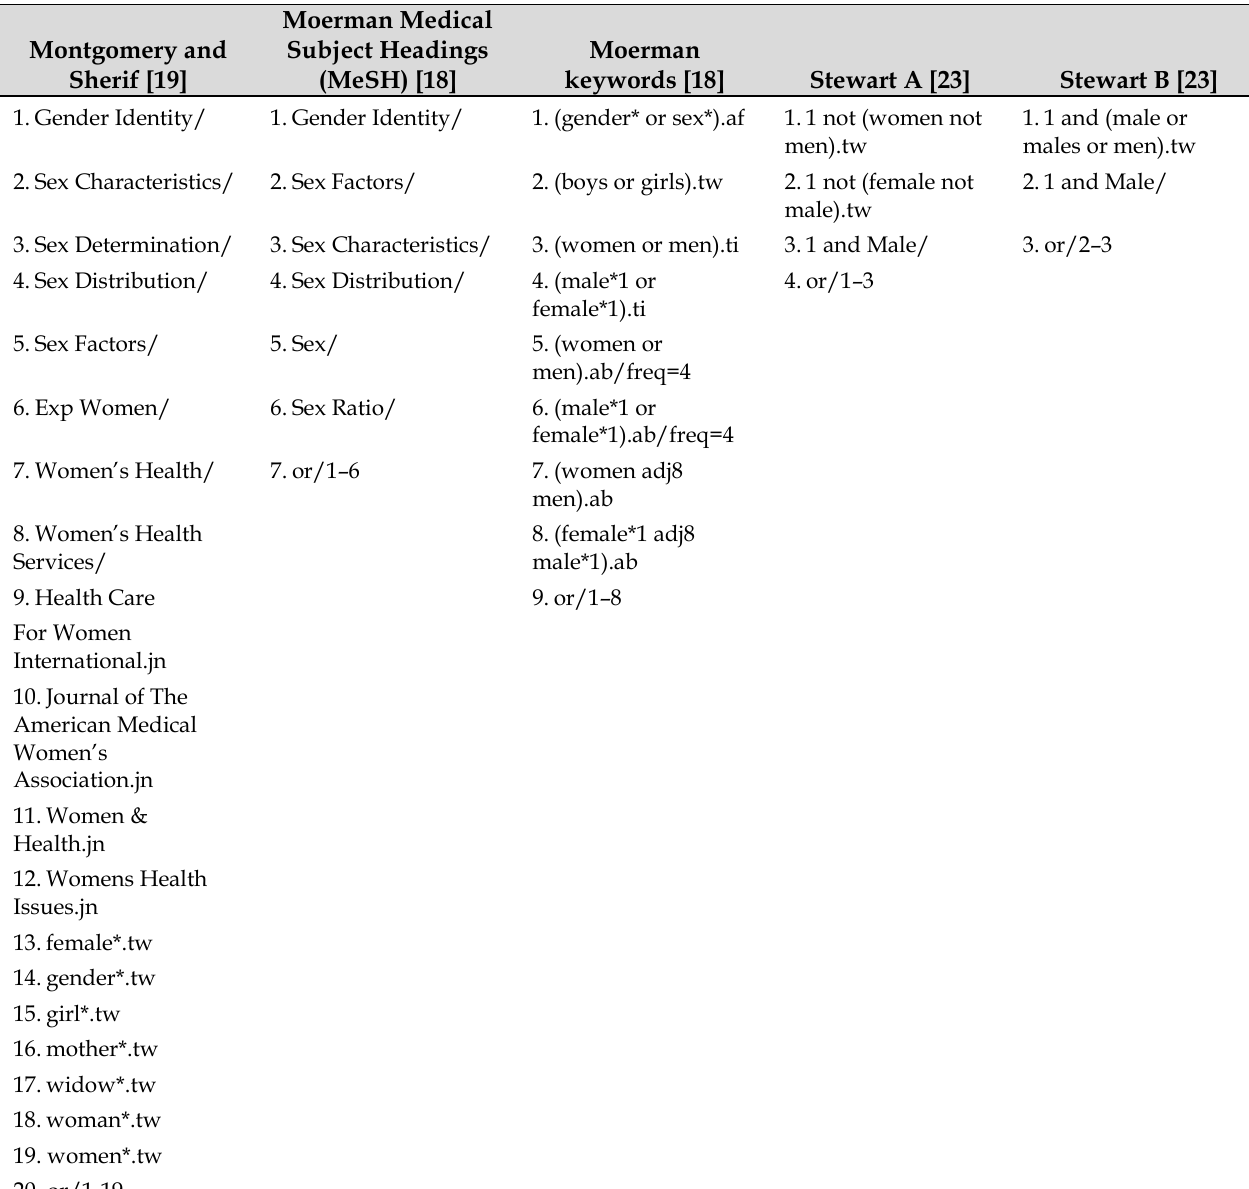
Table 1 Gender/sex-specific search filters (previously published) Montgomery